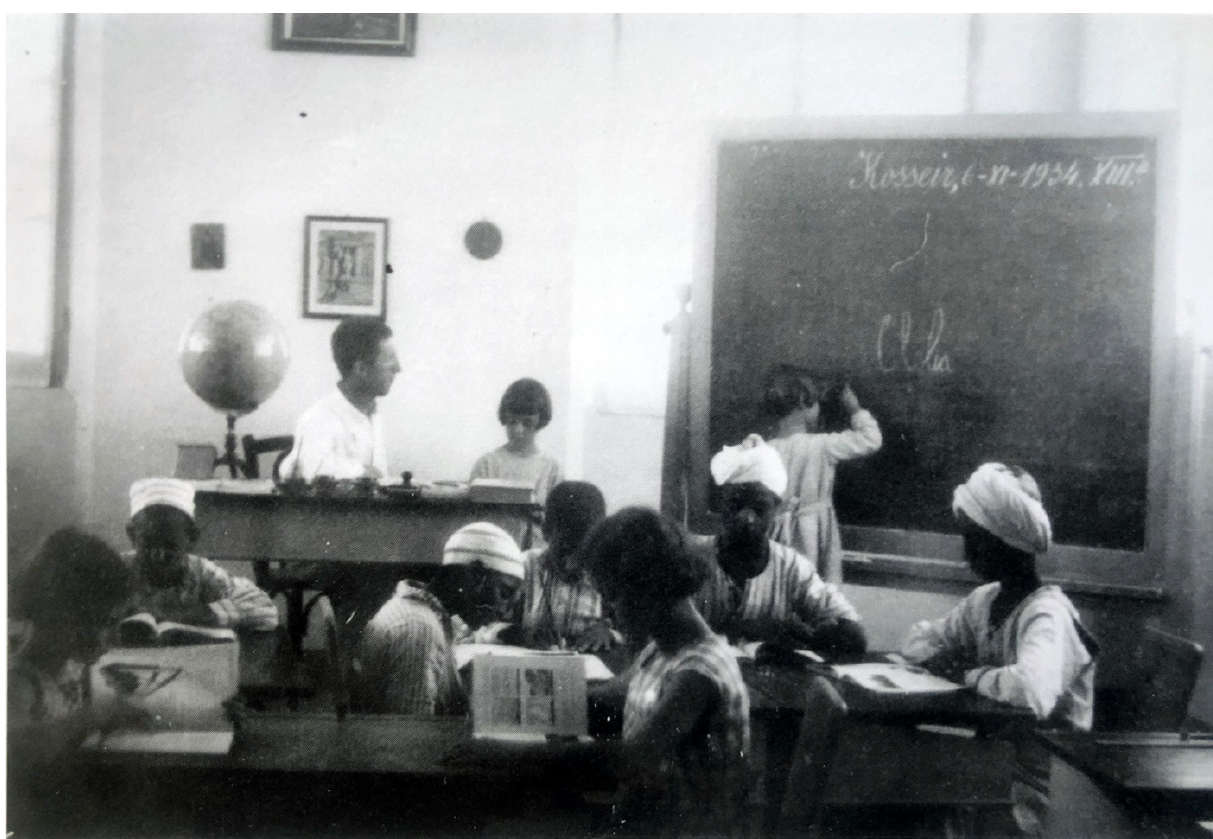
Figure 6. Egyptian and Italian pupils attending class in the elementary school at the coastal plant. Source: Pellegrini (2011, p. 142).